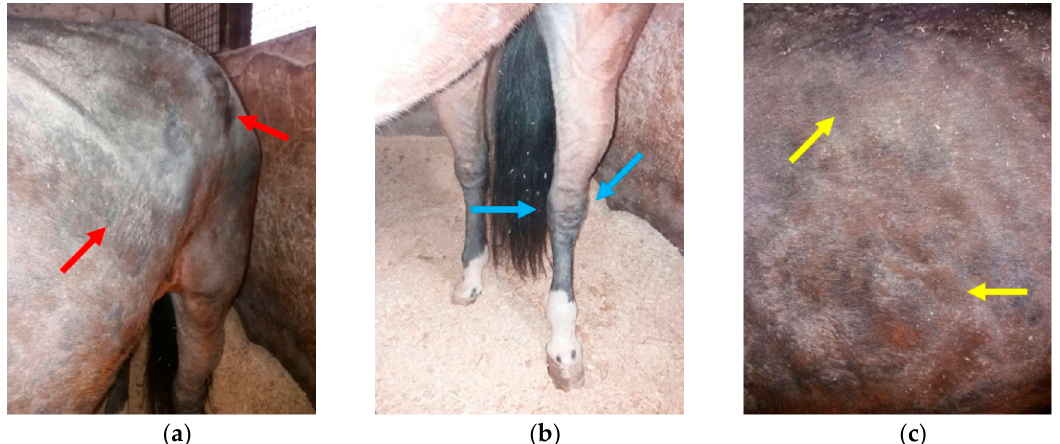
Figure 7. Gross photos of the horse at three-week follow-up. Alopecic regions showed new hair growth with fewer crusts on the abdomen and back ( a ), tarsal area ( b ) and thorax ( c ).